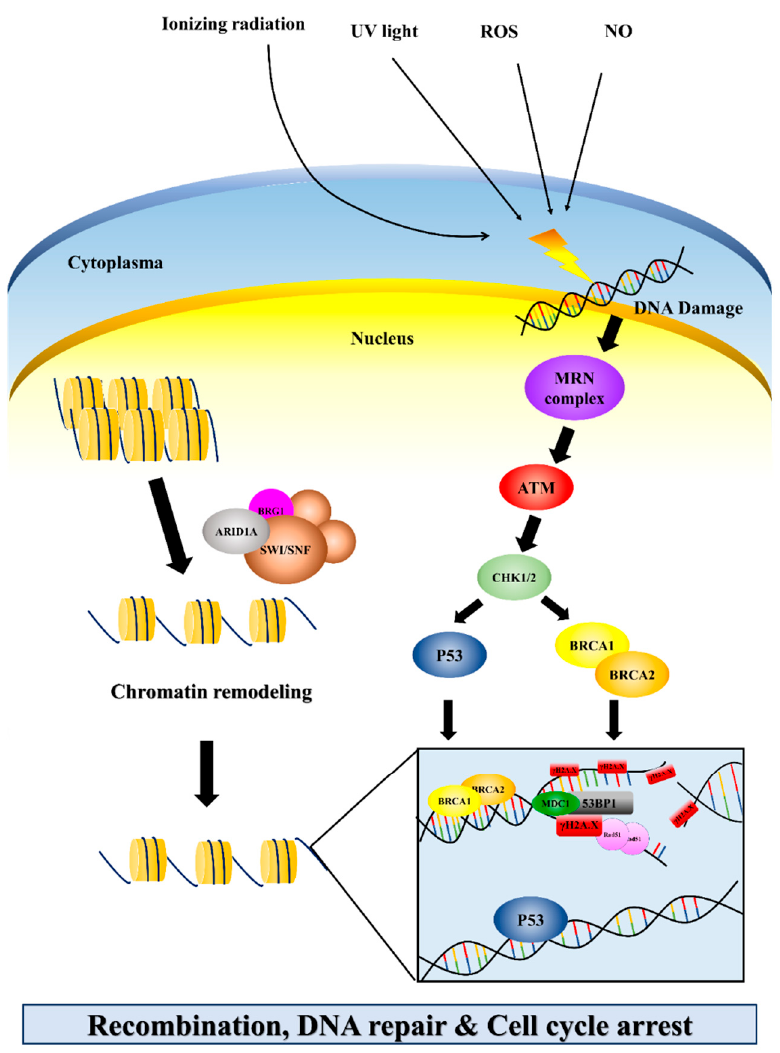
Figure 4. Schematic depiction and overview of the chromatin remodeling and DNA repair pathways of ARDA1a, BRG1, ATM, BRCA1, and P53 after DNA damage. Examples of the molecules known to act on regulatory pathways are listed. Note that some critical components of the pathways have been omitted for clarity.